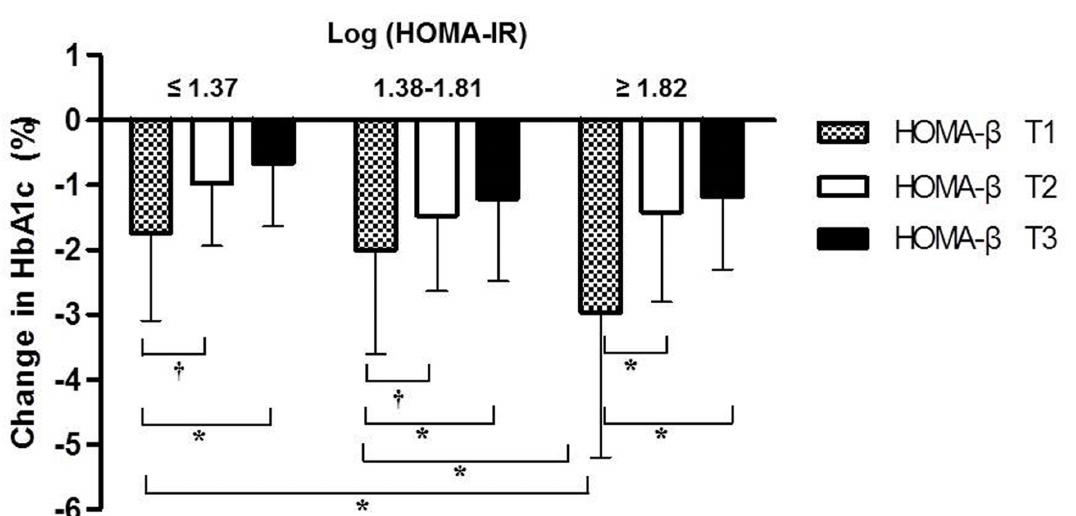
Fig 4. Changes in HbA 1c (%) after initial combination therapy with sitagliptin and metformin according to the tertiles (T) of HOMA-IR and HOMA- β at baseline. HOMA-IR and HOMA- β ; homeostasis model assessment of insulin resistance and β -cell function. Logarithmically transformed values of HOMA-IR and HOMA- β were used for analyses. Log (HOMA- β ) tertiles; T1 (cid:3) 3.65, 3.66 (cid:3) T2 (cid:3) 4.17, T3 (cid:1) 4.18. * P < 0.001, † P <